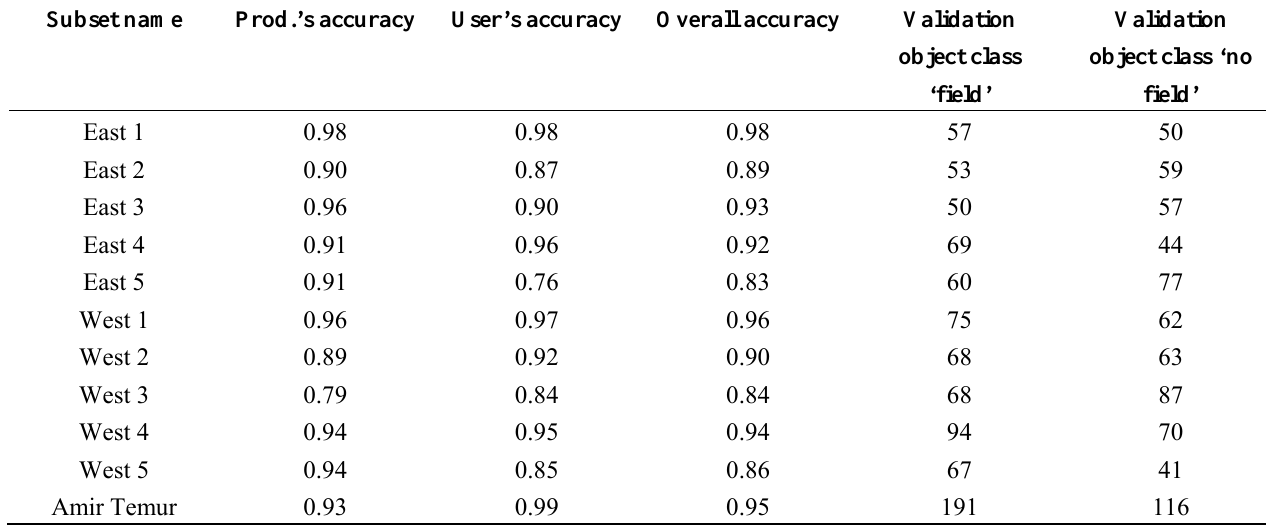
Table 3. Accuracy assessment for the separation of agricultural fields using SPOT